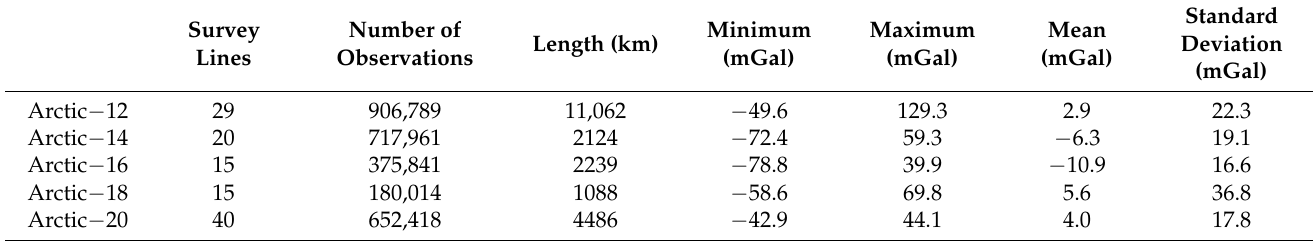
Table 1. Information on gravity survey for each cruise of Arctic research